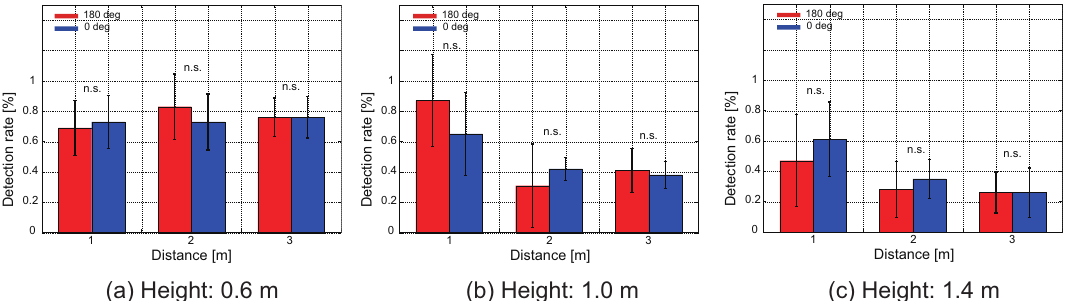
Figure 15. Detection rate of the control sensor arrangement. Mean and standard deviations of five iterative experiments are shown. The difference between ( a – c ) is the difference in height of the quadcopter. Red and blue bars mean the π rad condition and the 0 rad condition, respectively. We compared differences in detection rate under different heading angle conditions using the Wilcoxon rank sum test ( p <